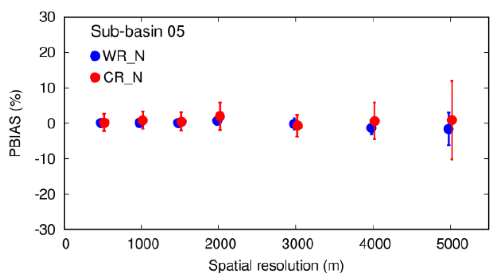
Figure 14. Percent bias profile with the standard deviation (vertical error bar) of the simulated